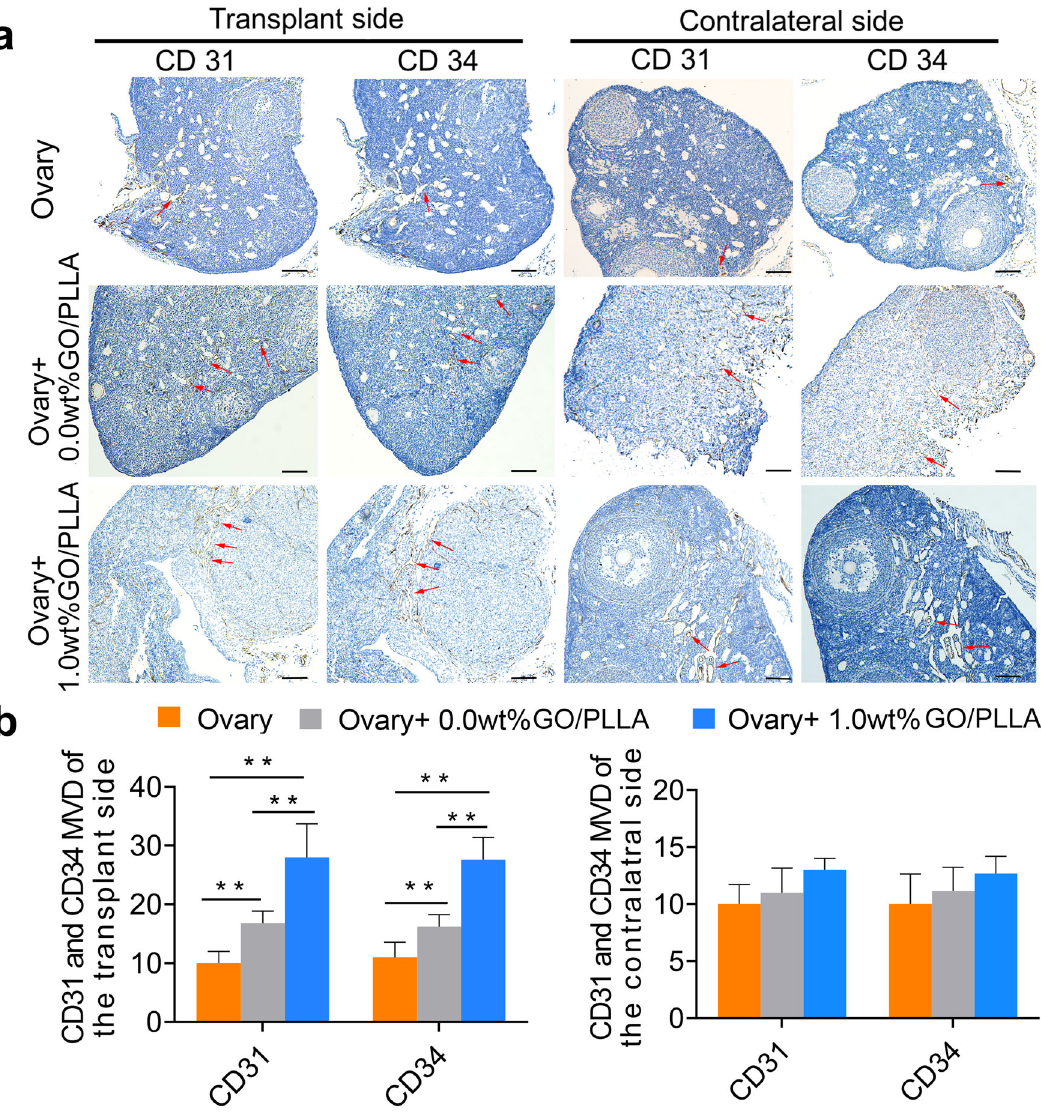
blood vessels. b Comparison of MVD by CD31 and CD34 between the three groups. Statistical signi fi cance levels are set at ** P < 0.01 by one- way ANOVA (Multiple comparisons). Data are presented as mean ± SD, scale bar: 200 μ